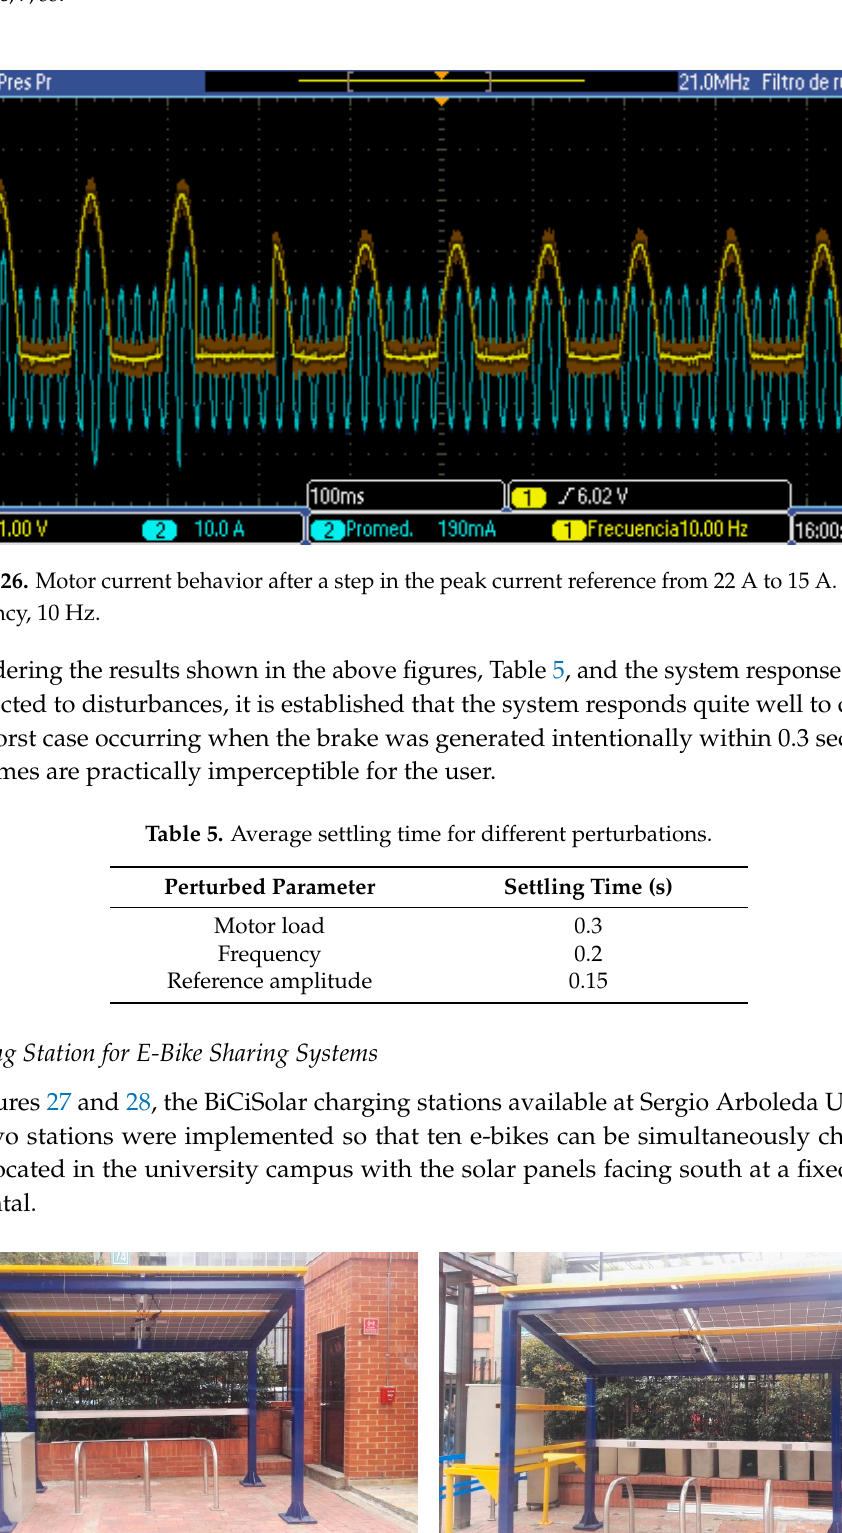
Figure 27. BiCiSOLAR charging station. East charging station ( left ) and west charging station ( right ).